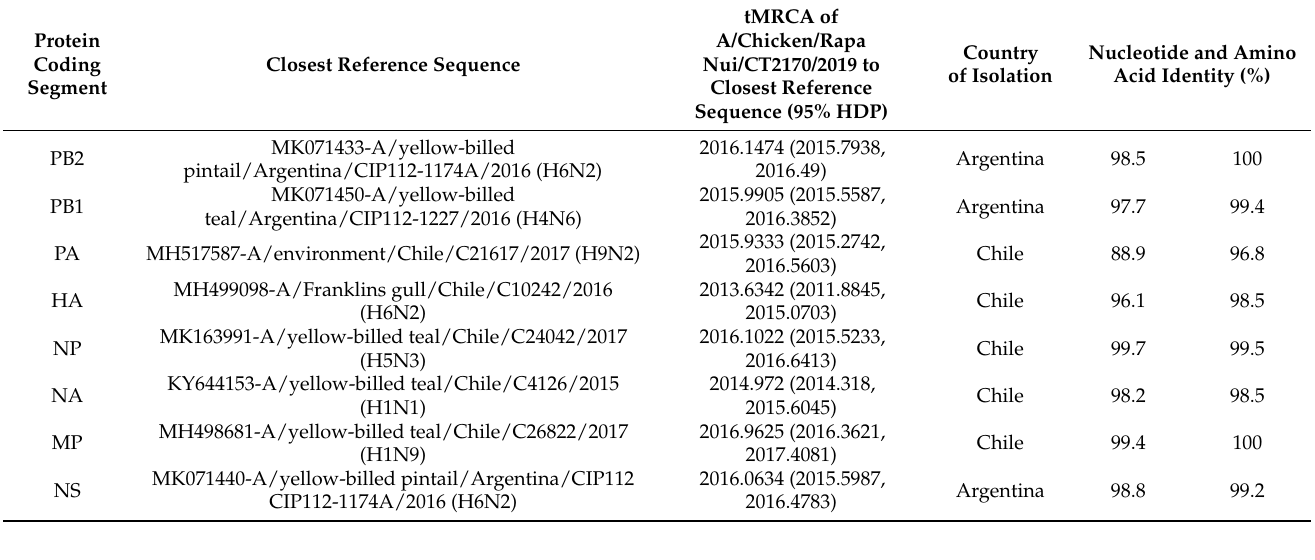
Table 1. Molecular characterization of the novel H6N1 virus. Closest reference sequence, time of the most recent common ancestor (tMRCA), country of isolation, nucleotide, and amino acid homology to the novel H6N1 virus shown.